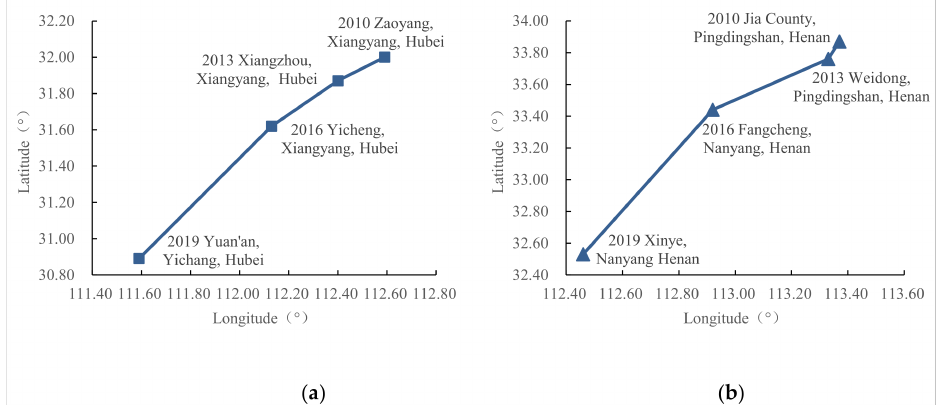
Figure 6. Shift chart of vegetable production center in China: ( a ) vegetable-sown area; ( b ) veg- etable yield.